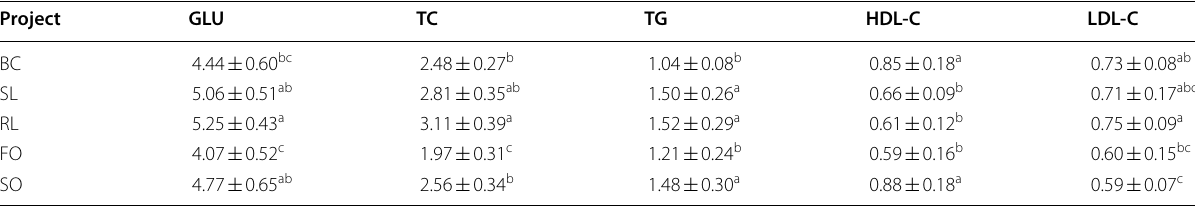
Different letters on the shoulder in the same column indicate significant difference in blood biochemical indices at the 0.05 significant level